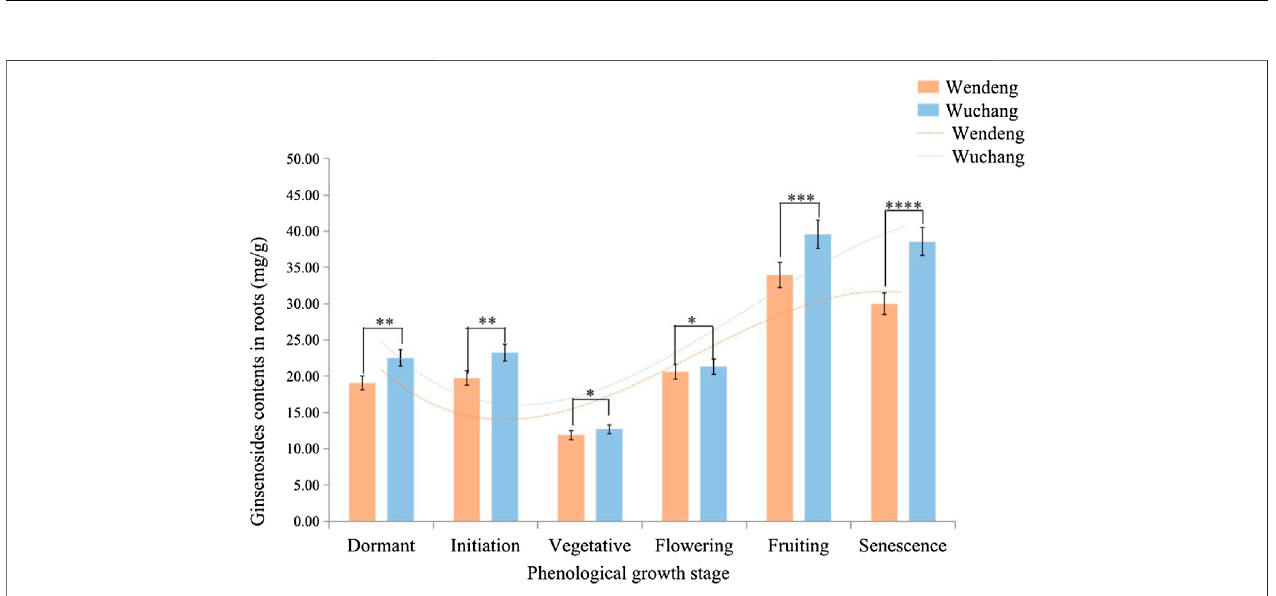
FIGURE 6 | Ginsenoside contents in roots at different phenological stages of American ginseng harvested from Wendeng and Wuchang. Note: The results are expressed as mean value ±SD (n = 3). * p < 0.05, ** p < 0.01, *** p < 0.001, **** p < 0.0001).